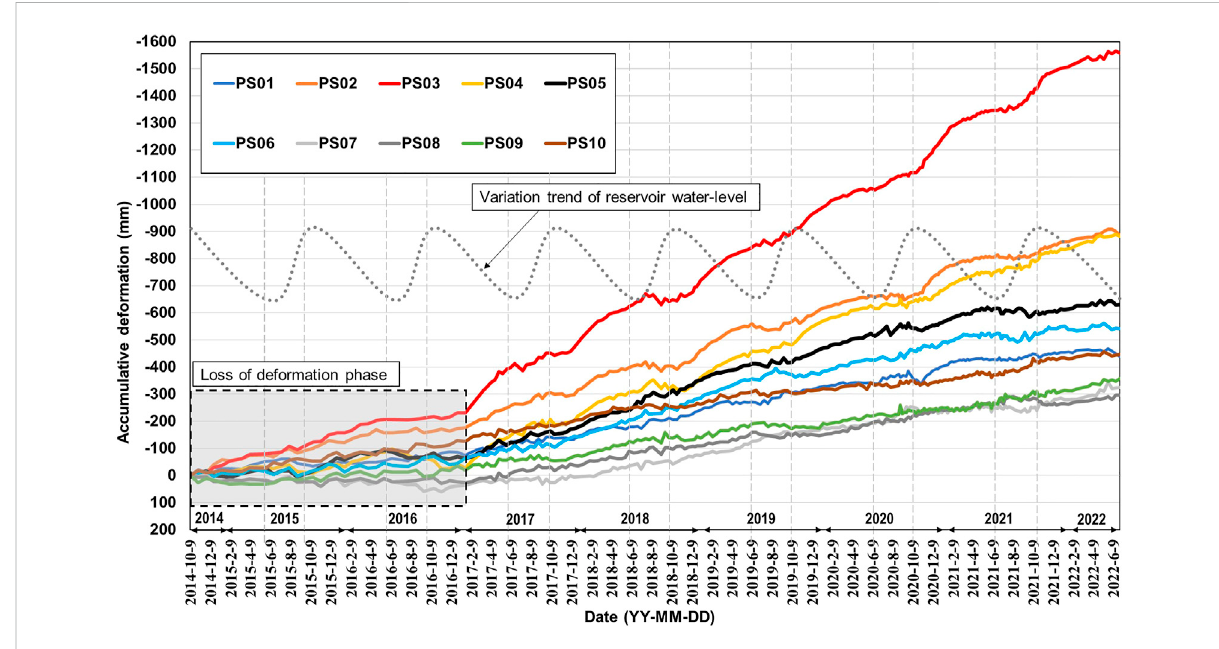
FIGURE 9 Cumulative displacement curves of 10 PS points monitored by SBAS-InSAR.